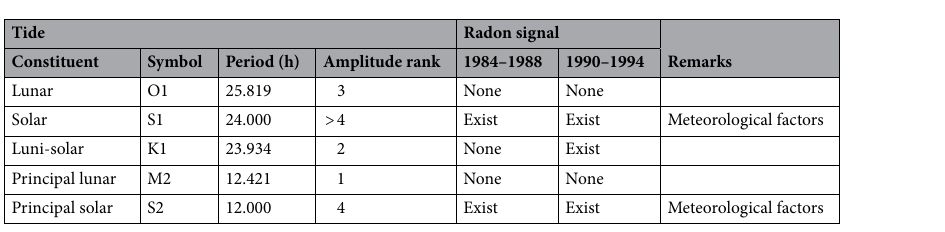
Table 2. Tidal constituents in the study area and radon